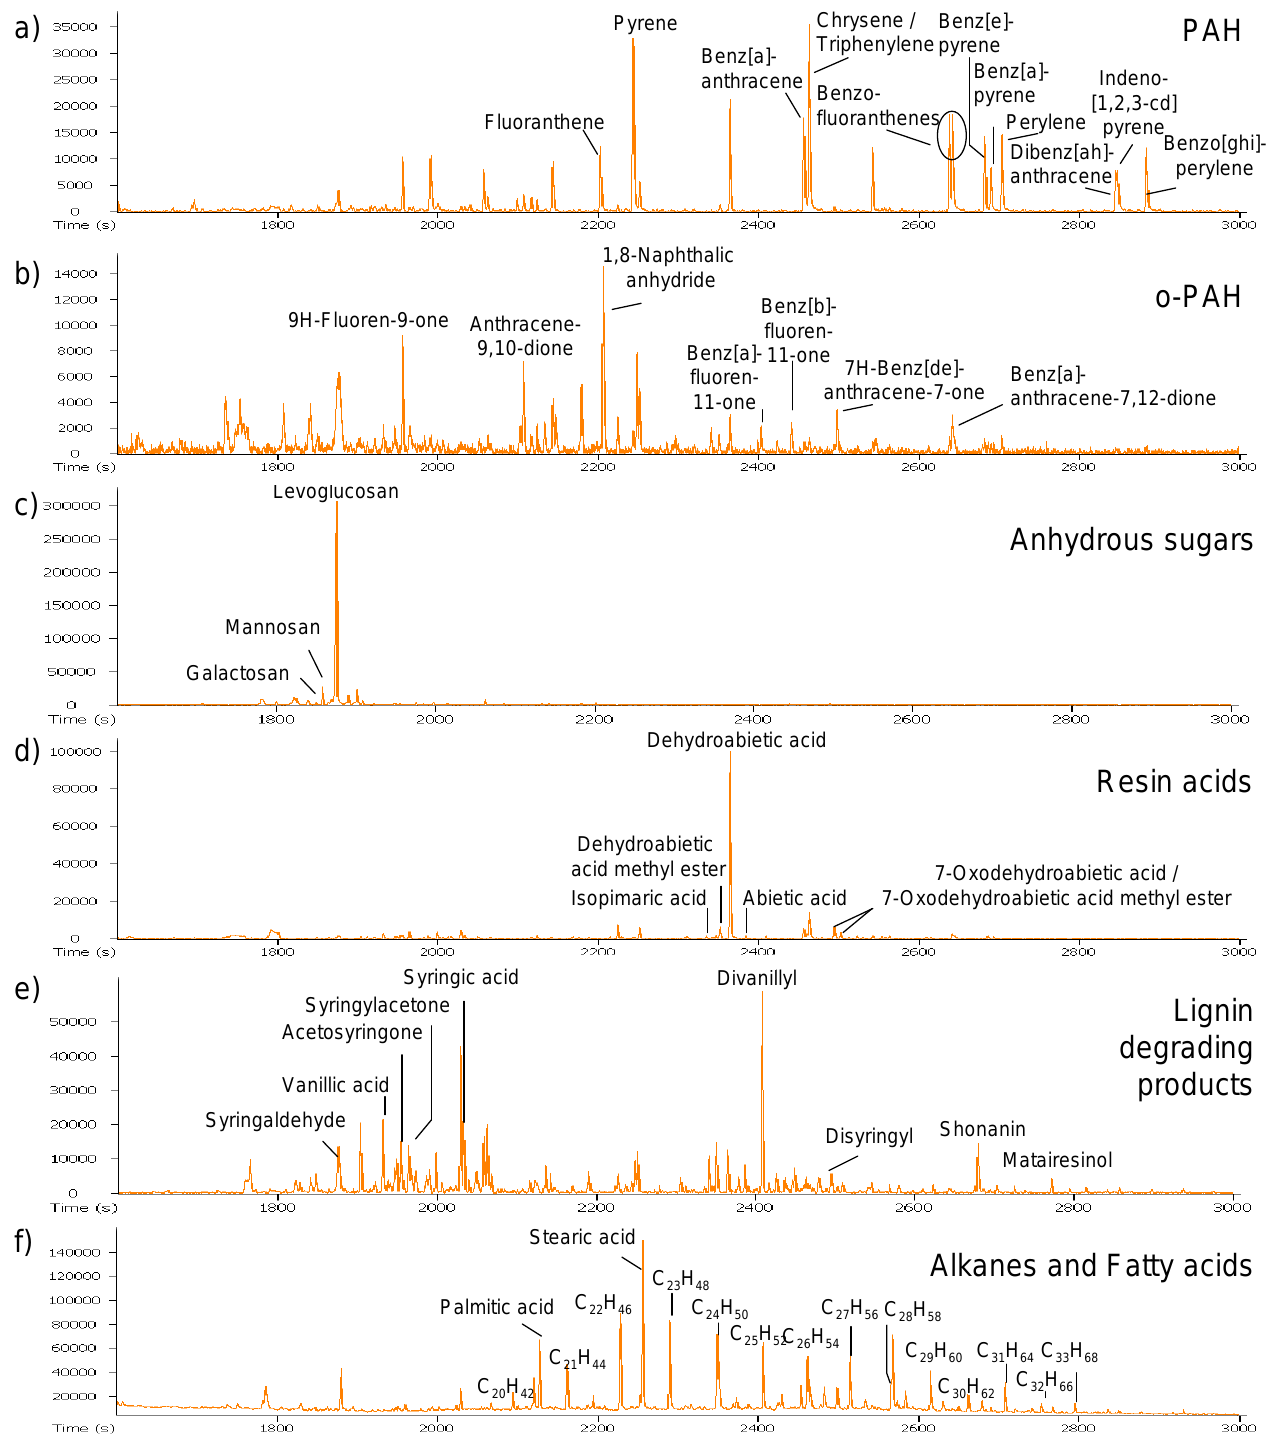
Fig. 2. Multiple ion chromatograms reflecting different groups of polar and non-polar analytes from a sample collected at the aerosol characterization site at the UAS (urban background): (a) polycyclic aromatic hydrocarbons (PAH) ( m / z 178+202+228+252+276+278), (b) oxidized PAH (o-PAH) ( m / z 126+158+180+196+230+258), (c) anhydrous sugars ( m / z 204+217), (d) resin acids ( m / z 239+241+253), (e) lignin degradation products ( m / z 194+209+224+238+279+297+327), (f) alkanes and fatty acids ( m / z